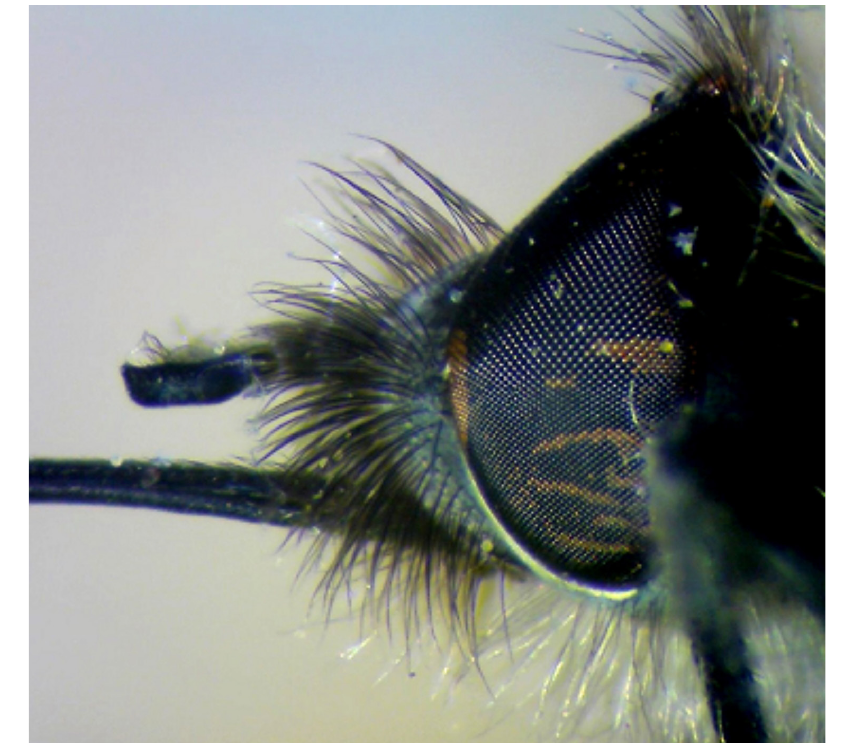
Fig. 5. Protypusia grata (Loew, 1859) comb. nov.,